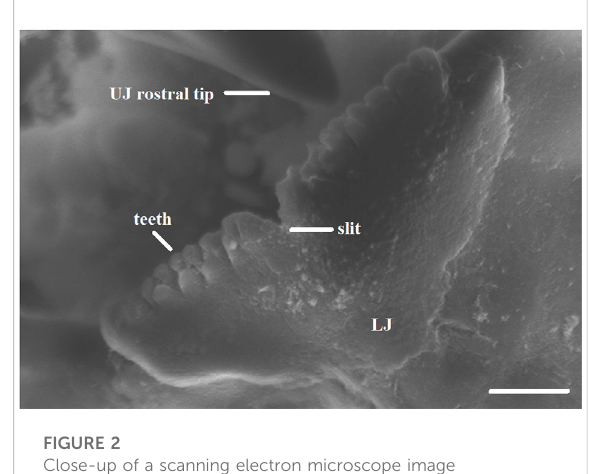
FIGURE 2 Close-up of a scanning electron microscope image indicating (lines) the teeth and slit in the lower beak (LJ) and the rostral tip in the upper beak (UJ) of an Illex argentinus paralarva